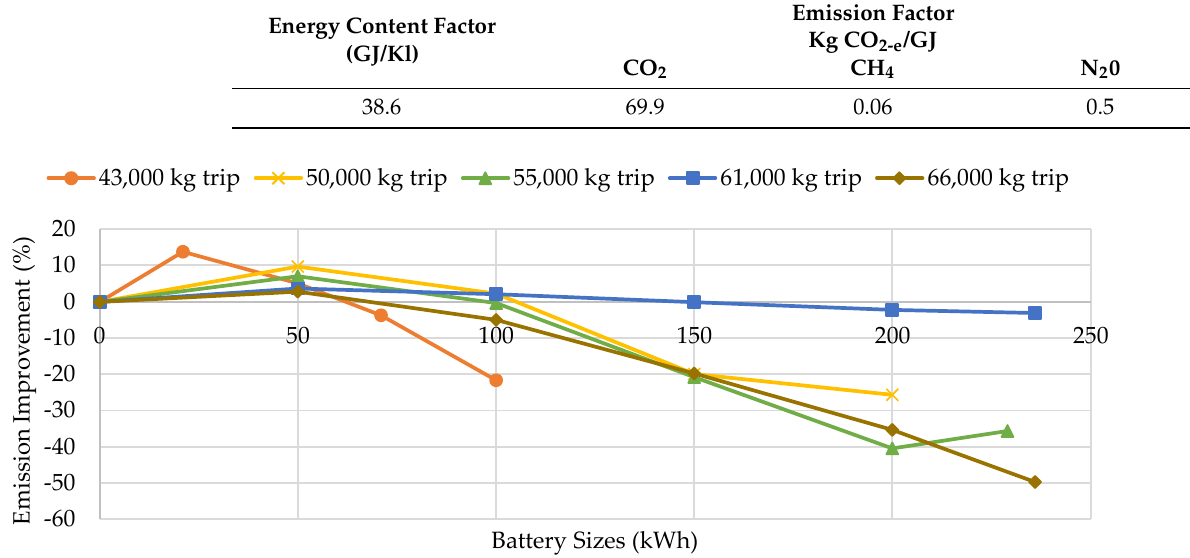
Figure 17. Total emission reduction in Victoria (0.96 kg CO 2-e /kWh).